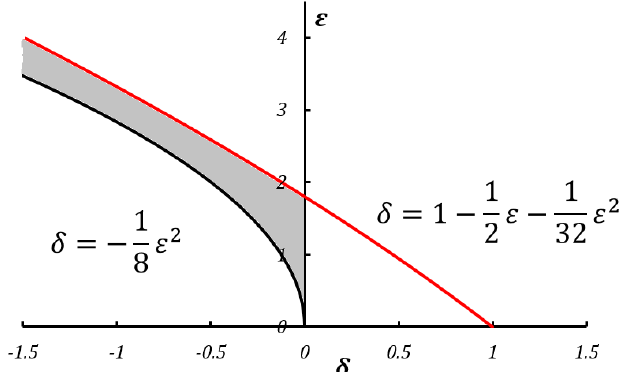
Figure 1. Ince – Strutt stability diagram for the Mathieu equation. The shaded region represents the domain of stable solutions for a tensile-loaded beam.